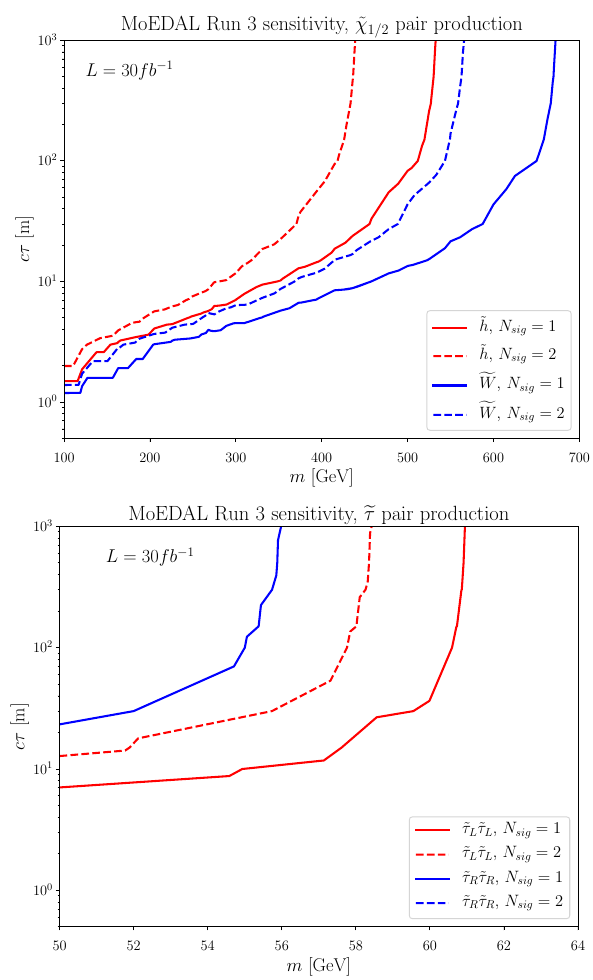
Fig. 3 The expected sensitivities of MoEDAL for various long-lived electroweakly-interacting sparticle species, assuming 30 fb − 1 of inte- grated luminosity. Upper panel: charginos, lower panel: